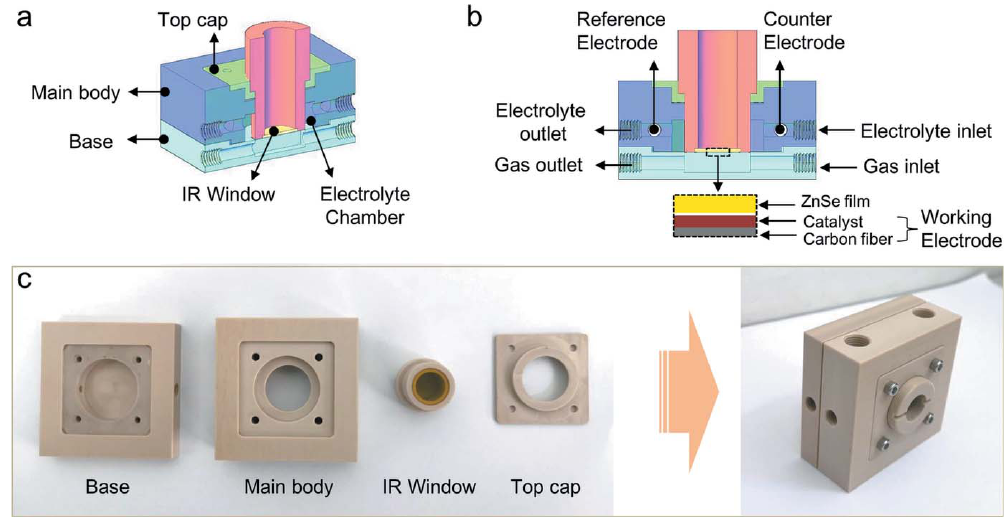
Figure 1 Schematics of the in situ FTIR cell observed from the side ( a ) and from the front ( b ). ( c ) Photographs of the in situ FTIR cell parts (left) and fully assembled